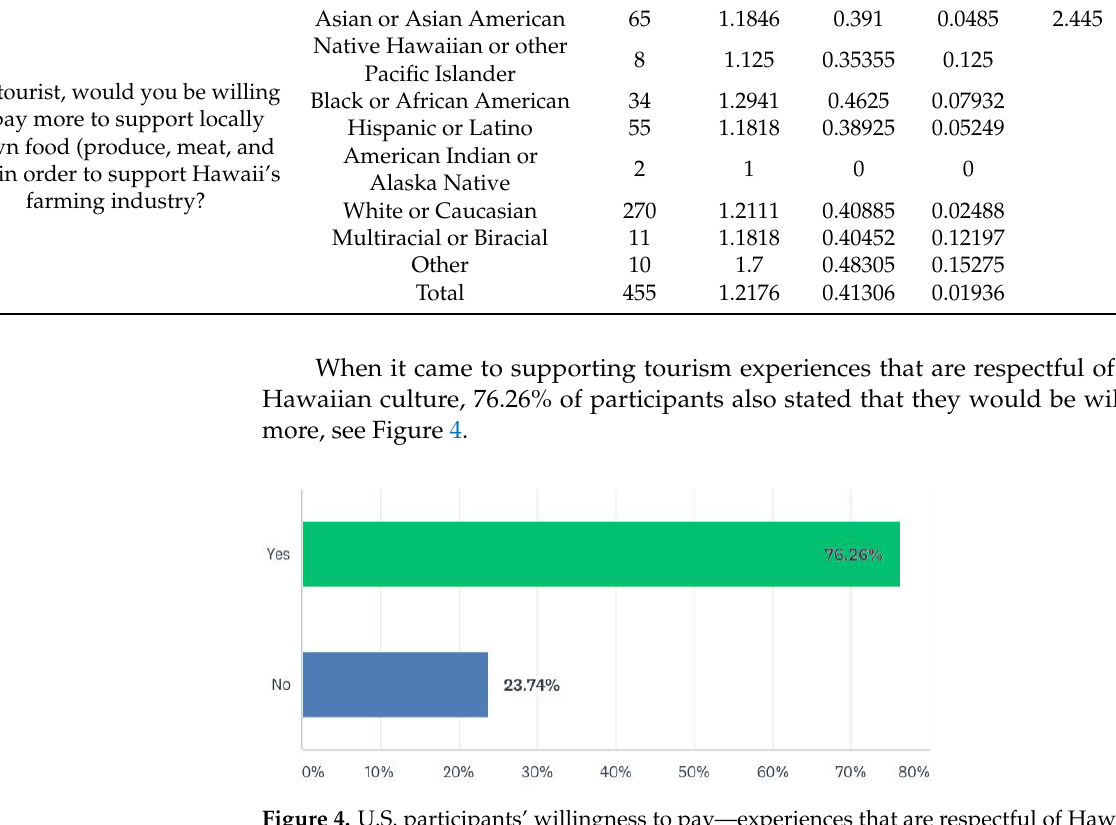
Figure 4. U.S. participants’ willingness to pay—experiences that are respectful of Hawaiian culture. Note: responses to the question “As a tourist, would you be willing to pay more to support tourism experiences that are respectful of the Native Hawaiian